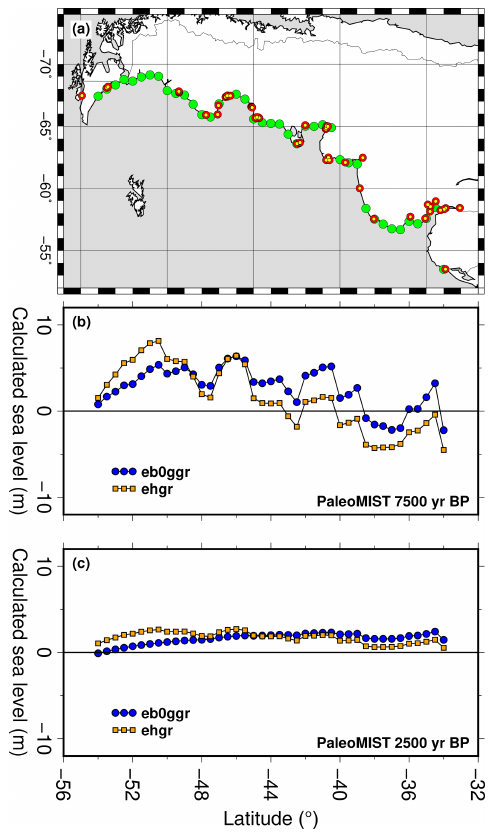
Figure 11. Calculated sea level along the coast of southeastern South America. We use the PaleoMIST ice sheet reconstruction (Gowan et al., 2021) to illustrate the variability in sea level dur- ing the Holocene. (a) Map showing where sea level was calculated (green dots) and the location of sea-level indicators described in our database (red dots). Calculated sea level at (b) 7500BP (ap- proximately when Holocene minimal ice extent was reached) and (c) 2500BP. The results of calculated sea level with two differ- ent Earth models are shown. ehgr (continental-style Earth model): 120km thick elastic lithosphere, 4 × 10 20 Pas upper mantle and 4 × 10 22 Pas lower mantle. eb0ggr (tectonically active style Earth model): 60km thick elastic lithosphere, a 160km thick layer be- low that at 10 19 Pas, 4 × 10 20 Pas upper mantle, and 4 × 10 22 Pas lower